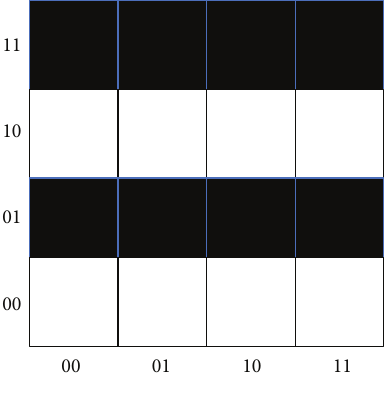
Figure 6: Fingerprint subgraph.